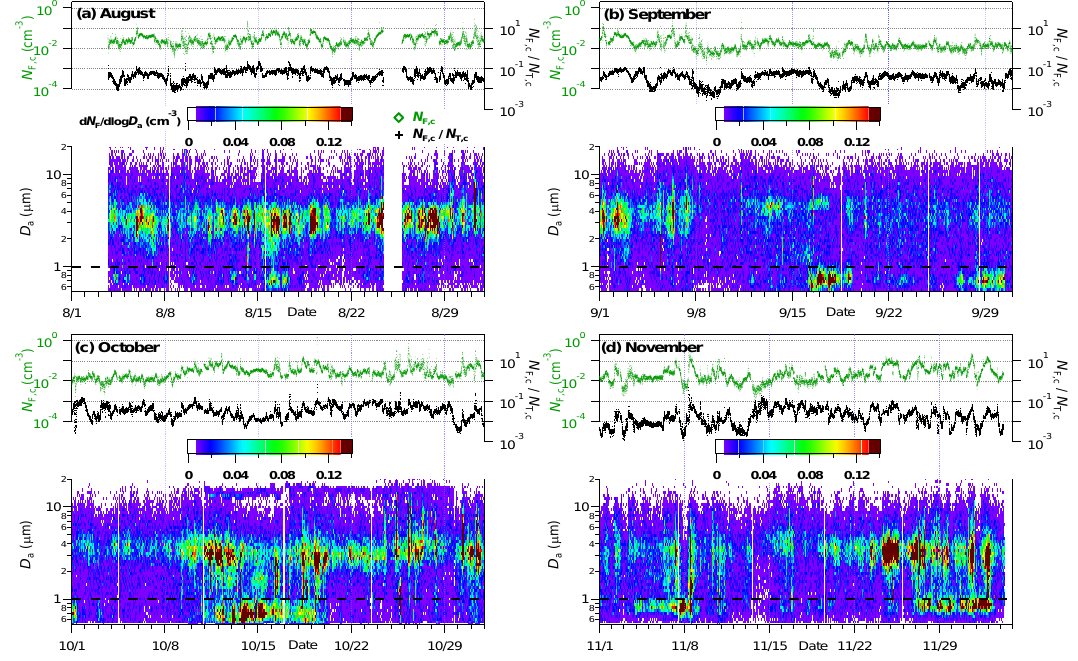
Fig. 1. Time series of fluorescent biological aerosol particle concentrations. Panel upper left: Integrated total coarse FBAP number ( N F , c ), green markers. Panel upper right: Number ratio of integrated coarse FBAP to TAP ( N F , c / N T , c ), black markers. Panel lower half: Size- resolved measurements (d N F /dlog D a ) for each 5-min sample over entire measurement period: (a) August, (b) September, (c) October, and (d) November (extending to 4 December). (Figs. 1, S7) in a general way to help the reader gain an overview of the observed concentration levels, trends, and variability before moving on to a more formal statistical treatment of the data (Fig. 2) and more detailed size-resolved analysis. Figure 1 shows time series of FBAP number con- centrations and size distributions measured with the UV-APS for each month of the